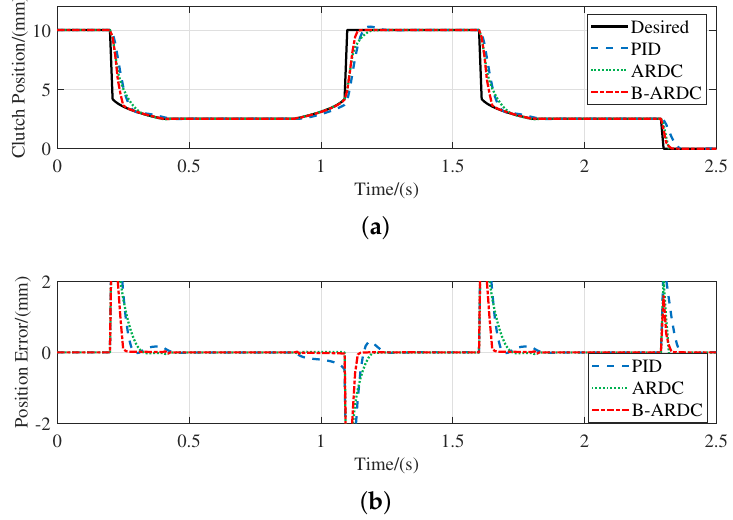
Figure 16. Performance comparison of position loop controllers under the third simulation condition: ( a ) Clutch Position; ( b ) Position